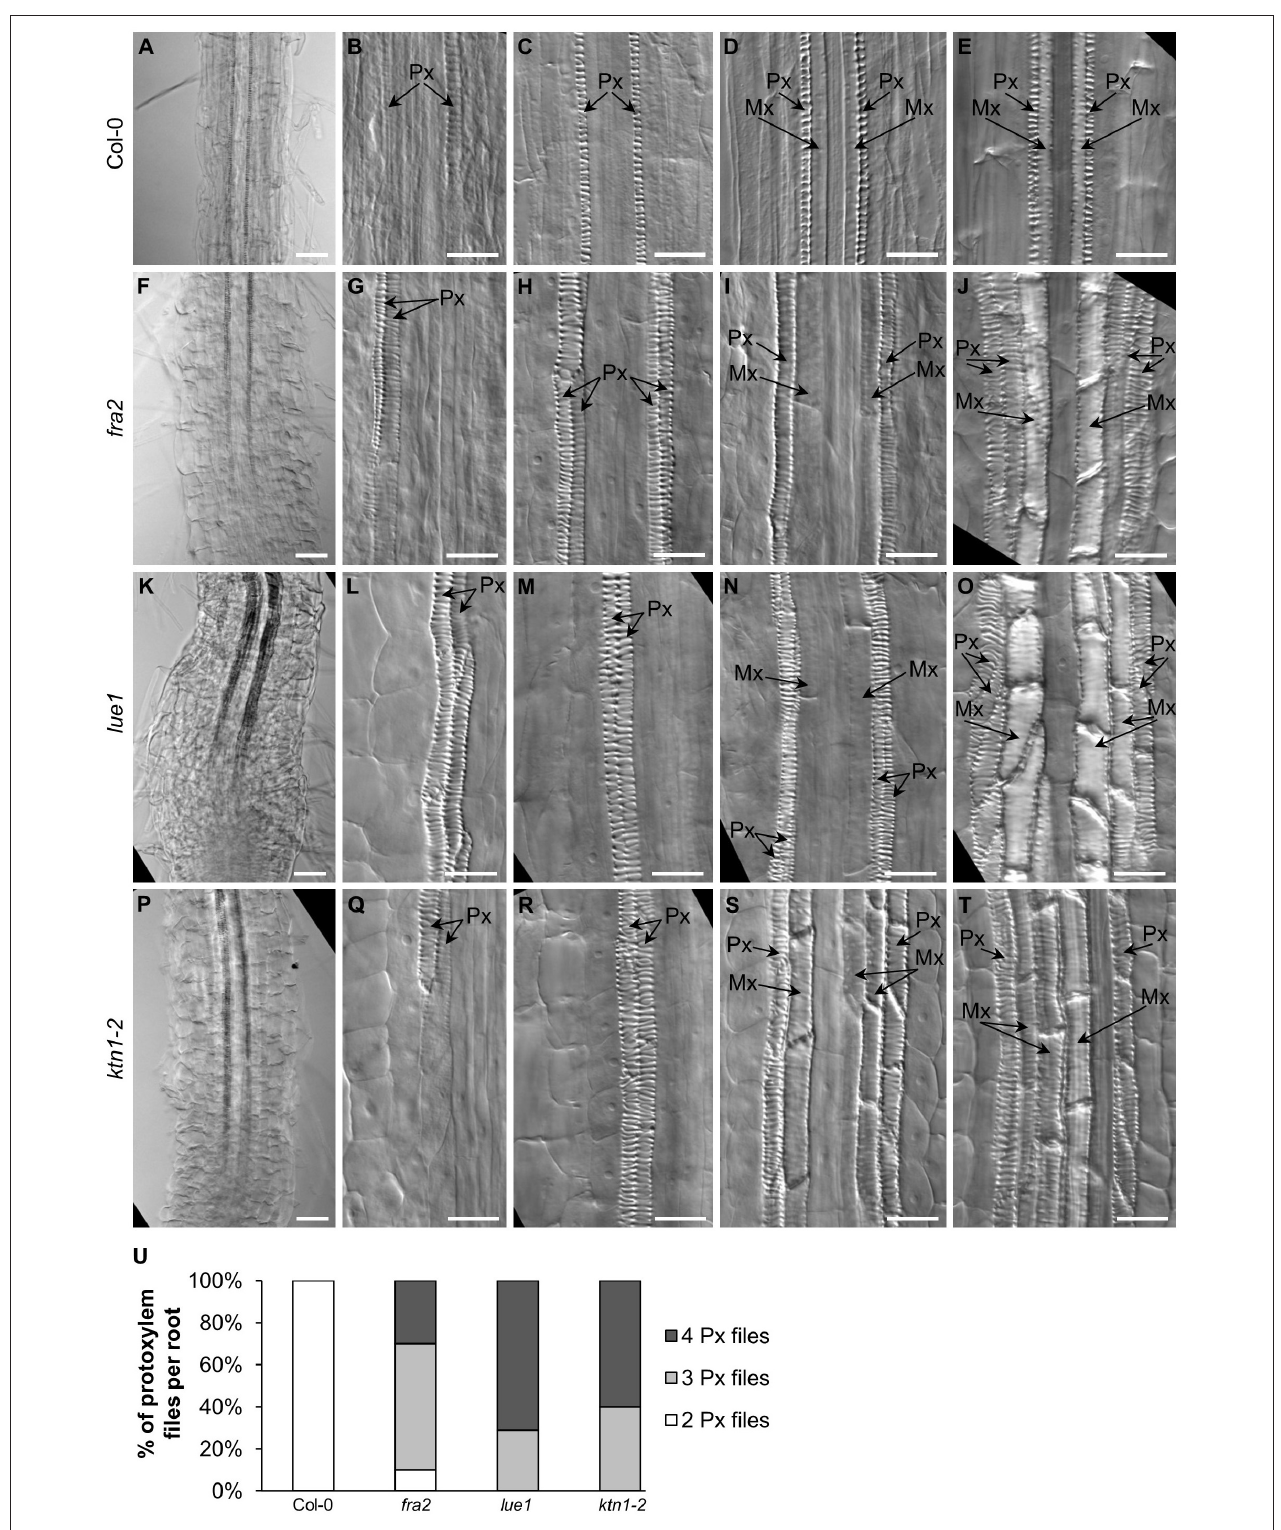
FIGURE 3 | Development and organization of xylem vascular tissue in primary roots of Col-0 and katanin1 mutants. (A–U) Differentiation and spatial organization of root protoxylem (Px) and metaxylem (Mx) vascular elements at different distances from the root tip in Col-0 (A–E) , fra2 (F–J) , lue1 (K–O) , and ktn1-2 (P–T) plants. Position of protoxylem (Px) and metaxylem (Mx) elements is indicated by arrows. (U) Frequencies of 2, 3, or 4 differentiated protoxylem cell files in mature part of examined roots in Col-0 and katanin1 mutant seedlings ( n = 9–11). Plants for analysis were 7 days old. Bars: (A,F,K,P) 50 µ m; (B–E,G–J,L–O,Q–T) 20 µ m.